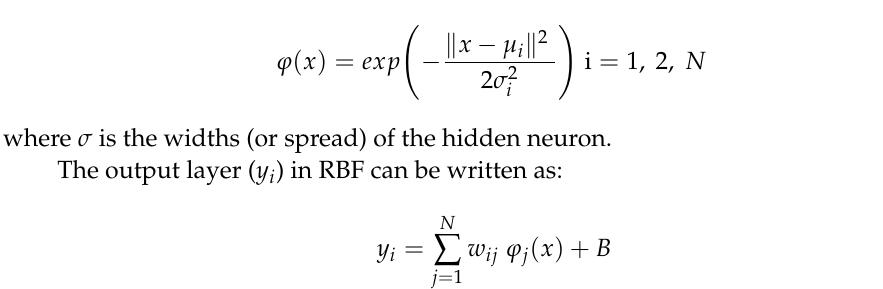
Figure 3. A simple structure of a multi-input RBF model. The RBFNN Gaussian function ( ϕ ) takes the form of: